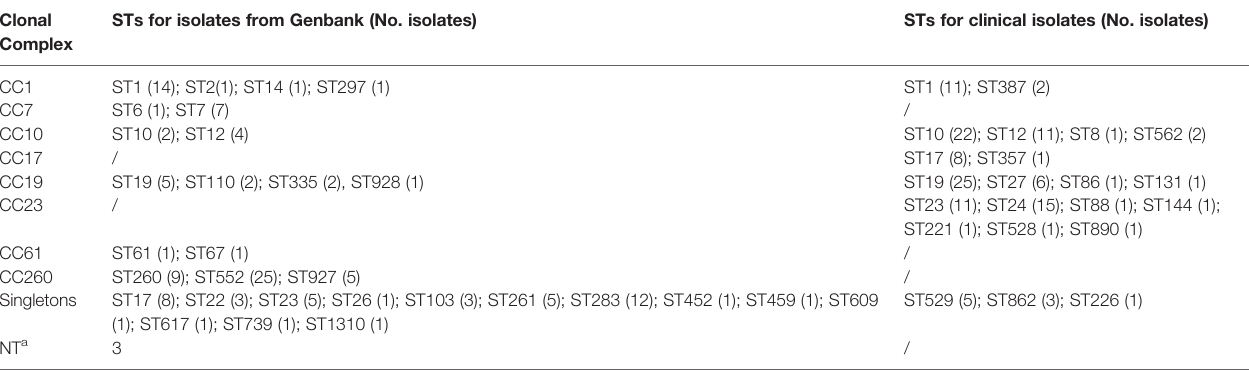
TABLE 1 | Sequence types (STs) grouped by clonal complex (CC) for GBS isolates recovered from GenBank and clinical GBS isolates recovered during 2014 – 2020. Clonal STs for isolates from Genbank (No. isolates) Complex